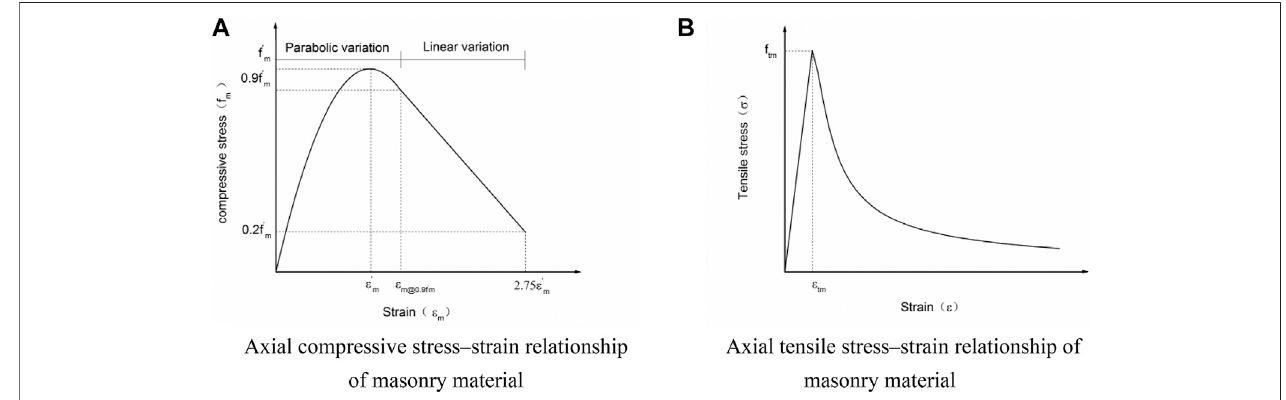
FIGURE 3 | Constitutive model of masonry material. (A) Axial compressive stress-strain relationship of masonry material. (B) Axial tensile stress-strain relationship of masonry